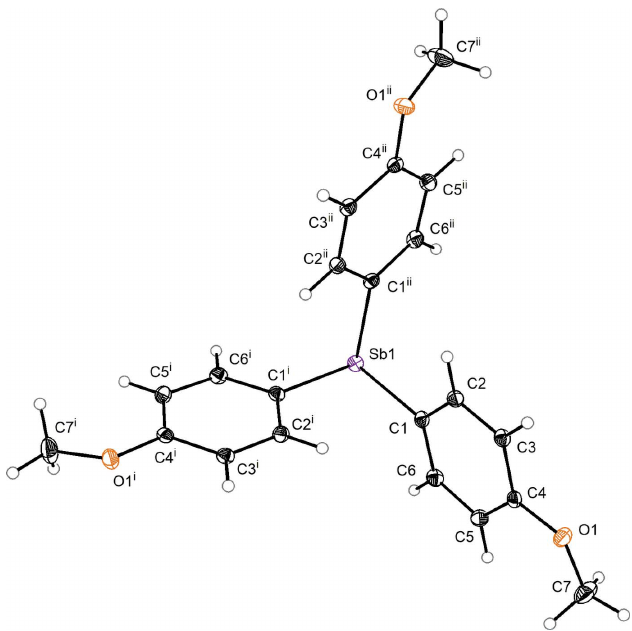
Figure 1 Displacement ellipsoid plot (50% probability) of the title compound.